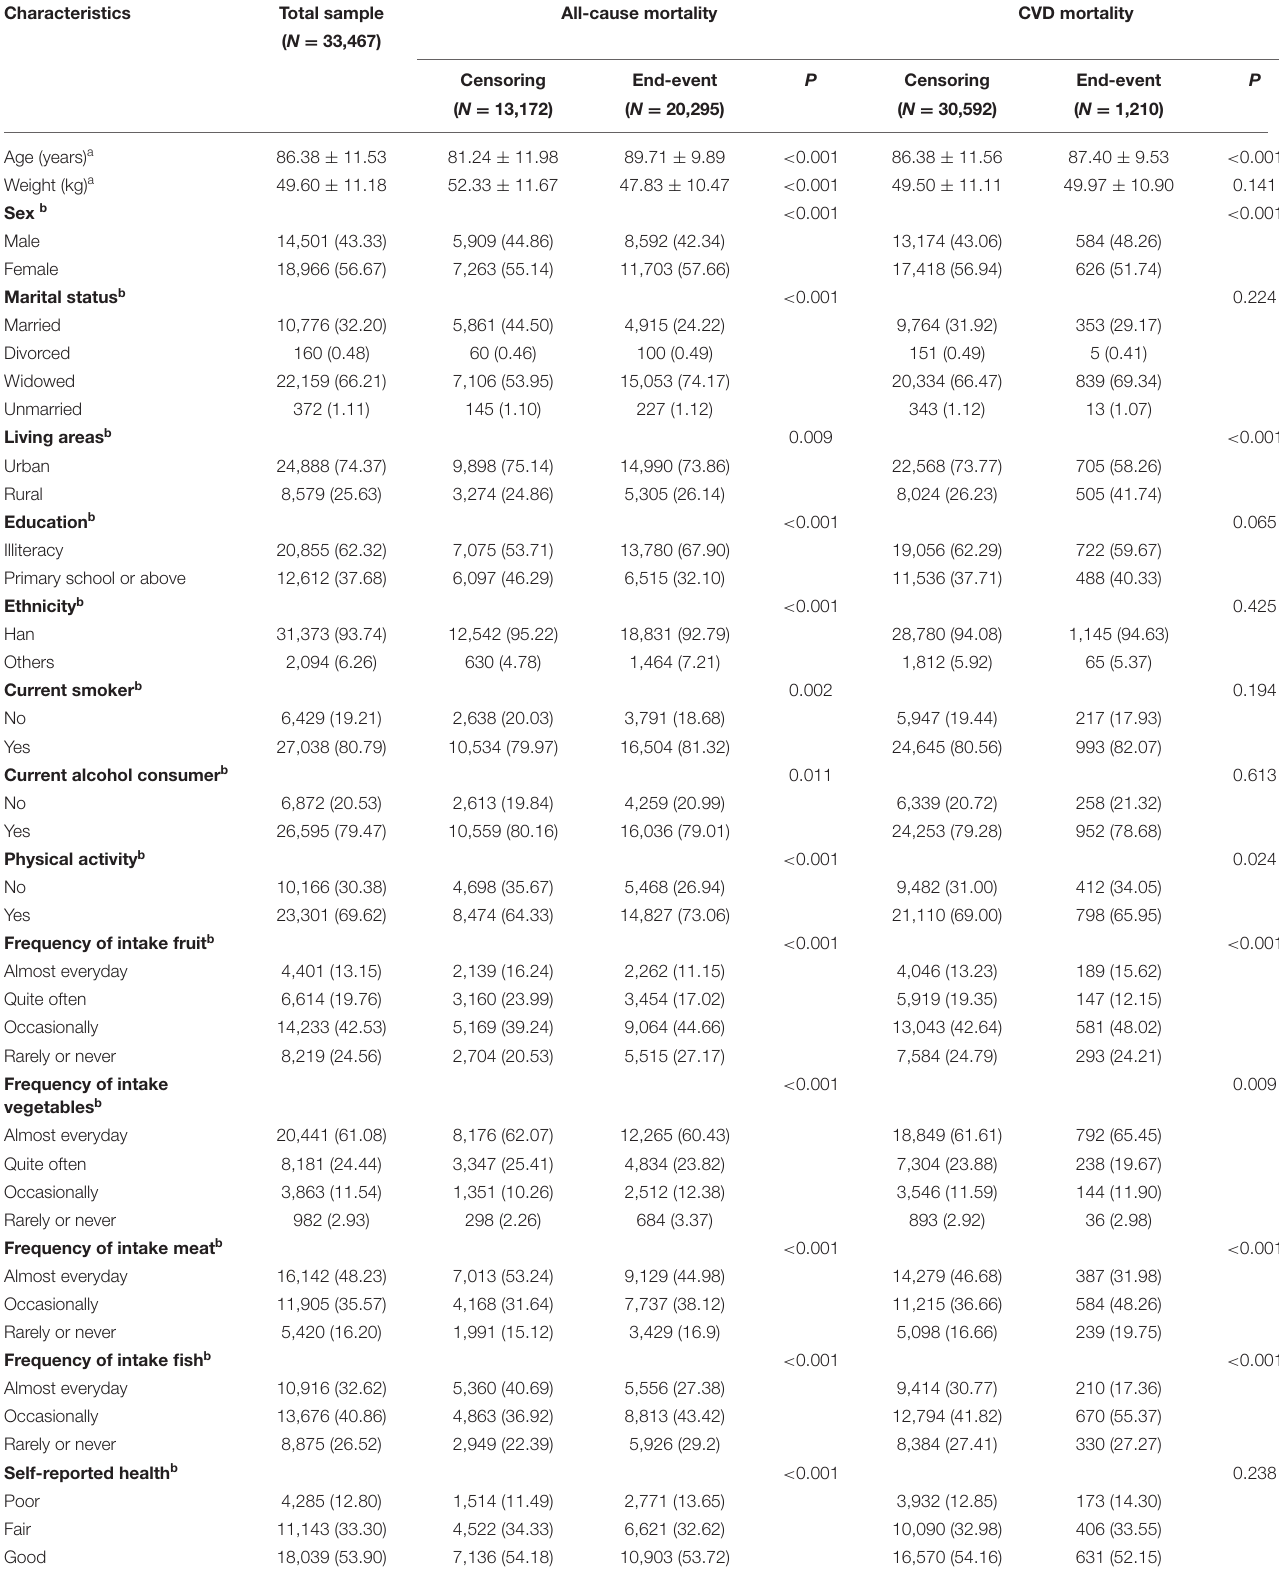
TABLE 1 | The characteristics of all participants at